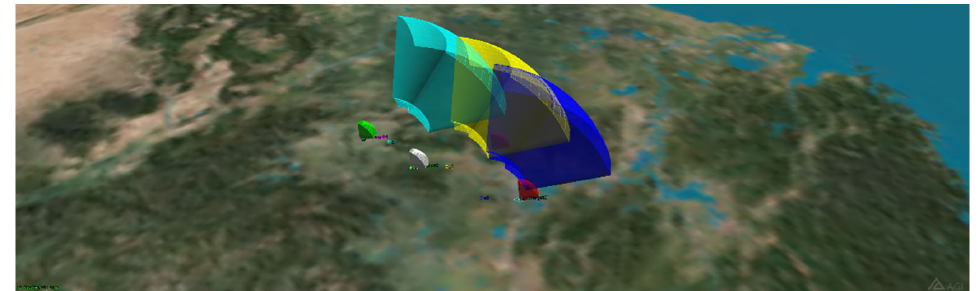
Figure 4. 2D schematic diagram of operational scenarios.